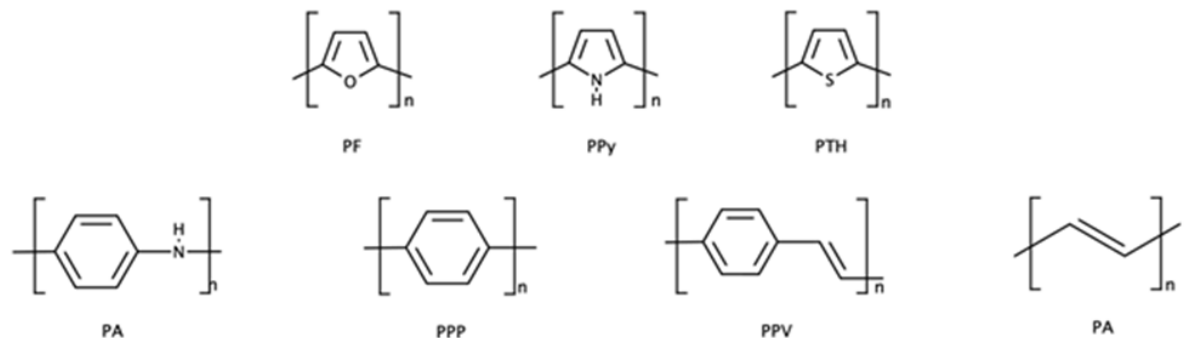
Figure 20. Schematic structures of polyfuran, polypyrrole, polythiophene, polyaniline, poly(para-phenylene), poly(phenylenevinylene), and polyacetylene.